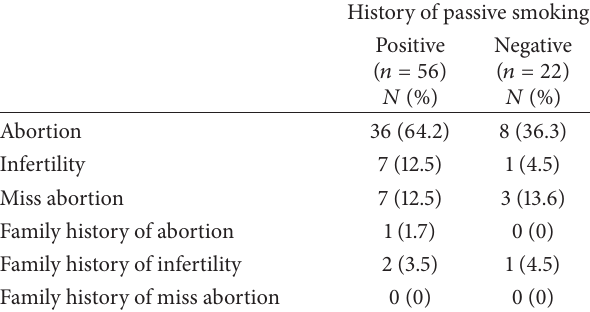
Table 1: The frequency of abortion and infertility in the case group with positive or negative history of passive smoking in childhood and